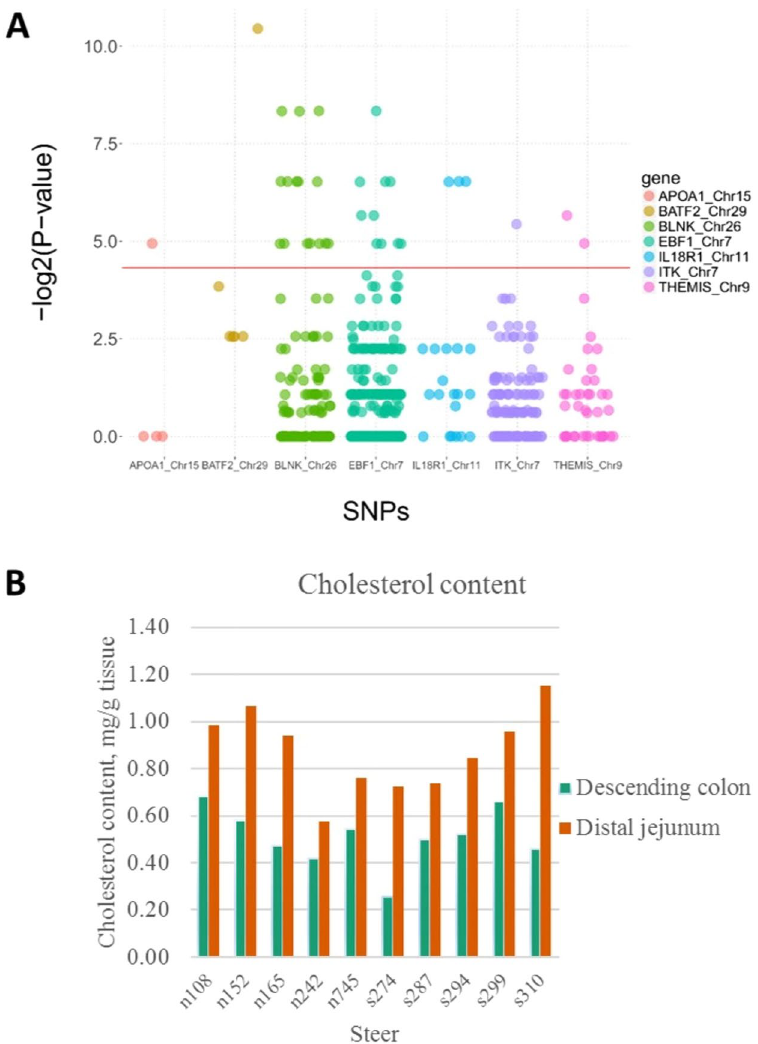
Figure 5. ( A ) SNPs detected from RNA-Seq data. The x-axis shows the location of a SNP on the genes, and y-axis shows the − log2(p-values). The SNPs that shows association with super-shedding phenomena are presented above the red line (p-value < 0.05). ( B ) Cholesterol quantification